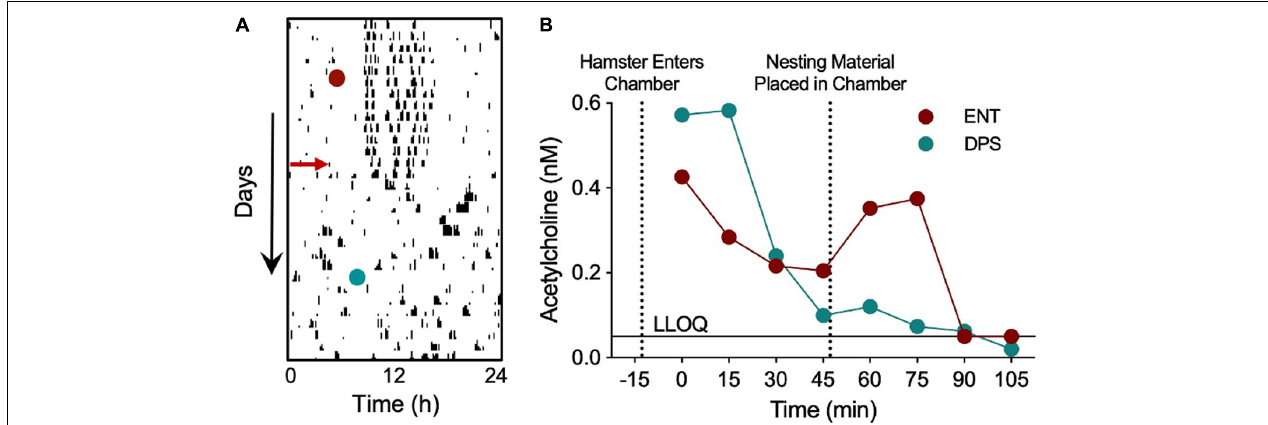
FIGURE 8 | Nest building failed to elicit increases in dentate Ach in a DPS hamster. In vivo microdialysis was used to quantify Ach concentrations during nest building in a single hamster before and after the DPS protocol. A microdialysis probe inserted into the dentate gyrus withdrew cerebrospinal fluid (CSF) samples at 15 min intervals, beginning 45 min before nesting material was provided, and continuing for 60 min afterward. Neostigmine (200 nM) was added to the samples to prevent enzymatic degradation of Ach. (A) Single-plotted actogram of a hamster before and after the DPS protocol (red arrow). Days and times of microdialysis given (red and green circles). (B) Ach concentrations (nM). Dotted lines indicate time when the hamster was placed in the microdialysis chamber and when nesting material was provided. LLOQ, lower level of quantification. Samples quantified courtesy of Brains On-Line (San Francisco, CA, United